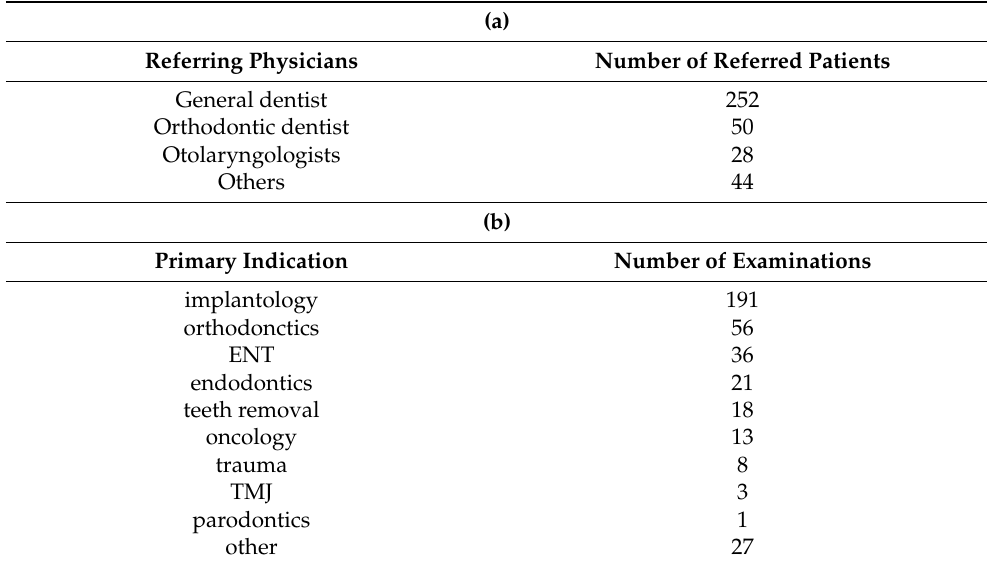
Table 3. ( a ) Subspecialization of referring physicians. ( b ) Frequency of primary indications for CBCT